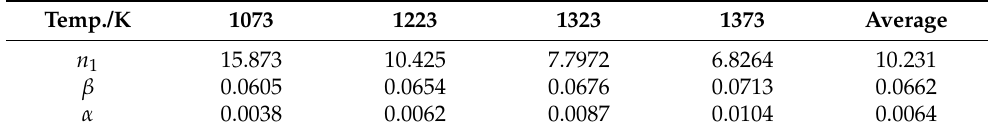
Figure 5. The fitting curves for 𝜎 − ln𝜀(cid:4662) . Table 1. The values of n 1 , β , and α under different deformation conditions.